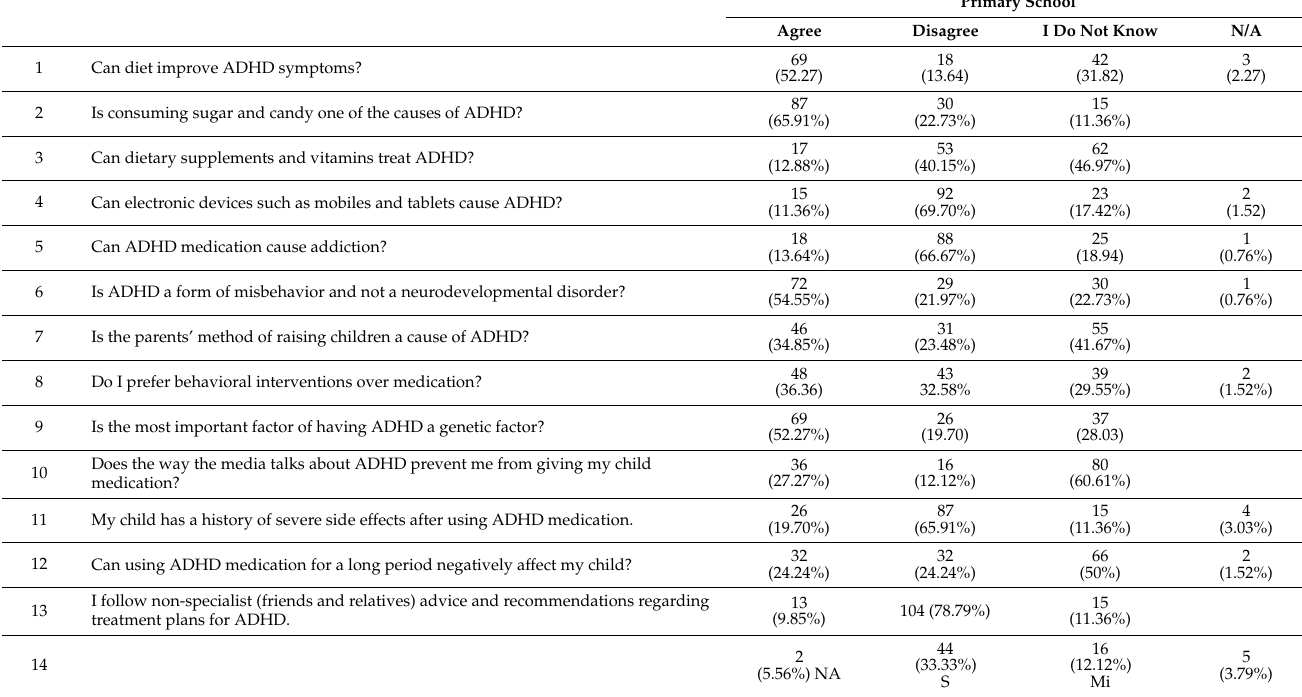
Table 3. Parental responses (primary school